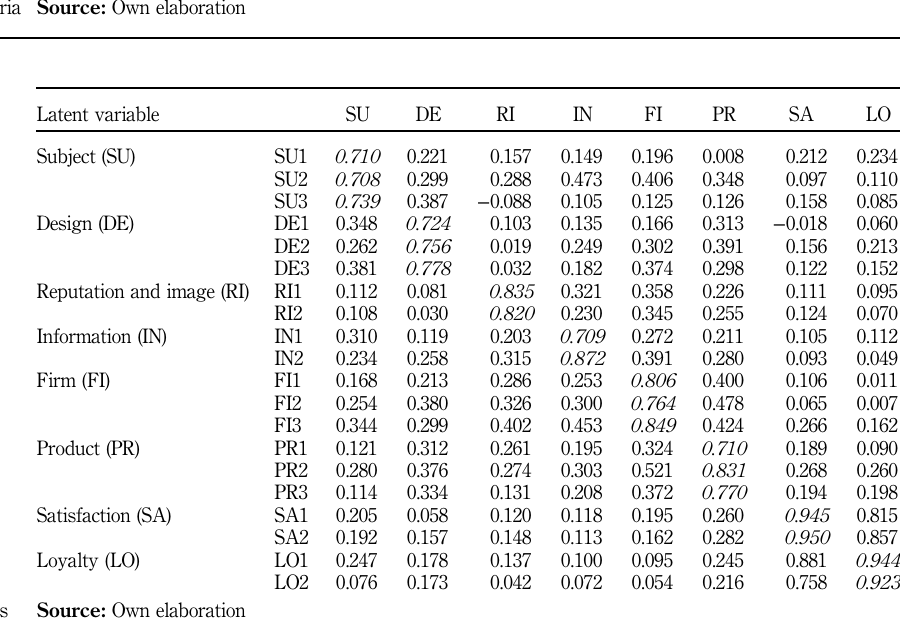
Table VI. Disciminant validity: Fornell Larcker criteria